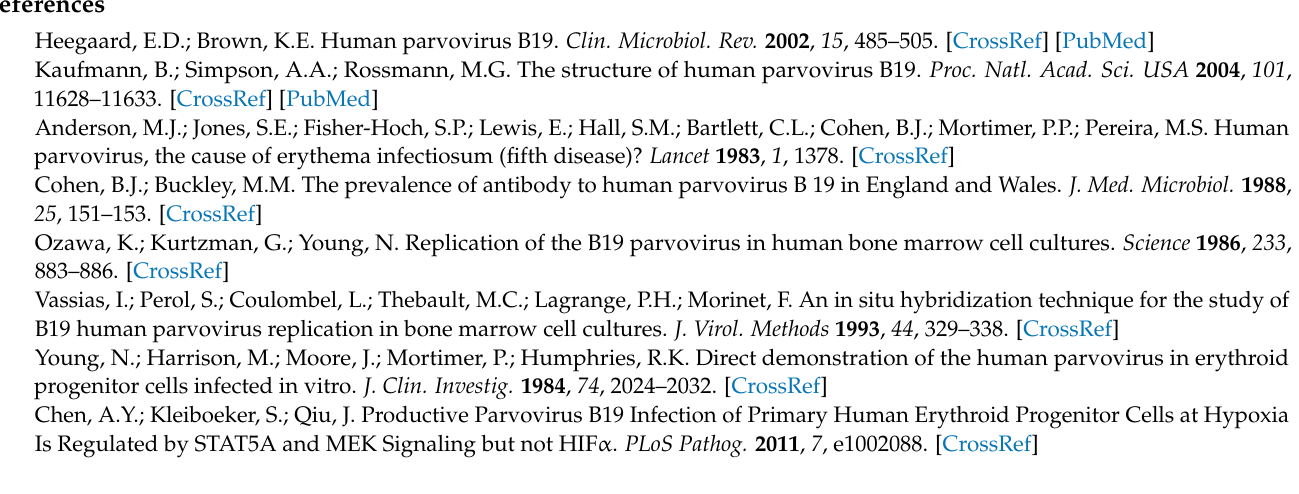
VP1u presentence in cells; Figure S3: Images of the original uncropped Western blots used for the preparation of Figure 4; Figure S4: Images of the original uncropped Western blots used for the preparation of Figure 5; Table S1: List of antibodies used for the cell characterization; Table S2: List of the antibodies used for the immunocytochemistry; Table S3: Primer sequences of the genes analyzed by real-time PCR; Table S4: List of the antibodies used in the Western